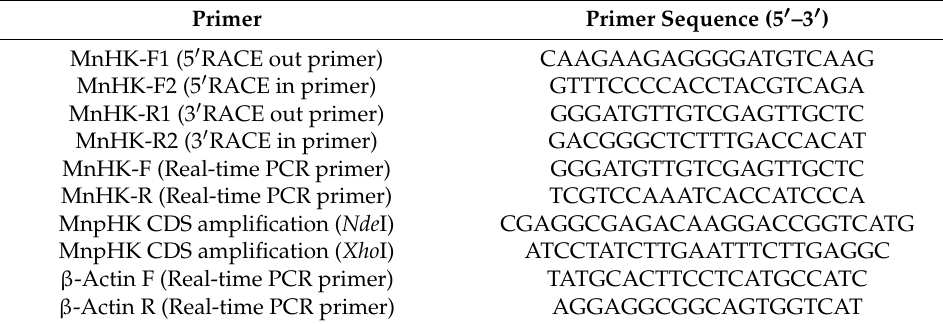
Table 2. List of primers used in this